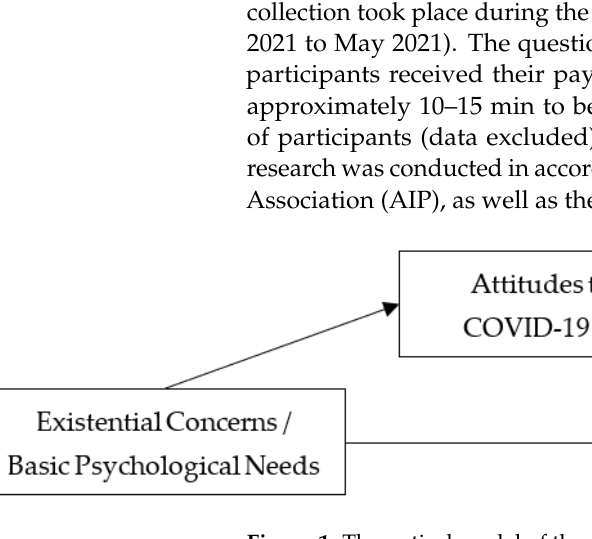
Figure 1. Theoretical model of the study.